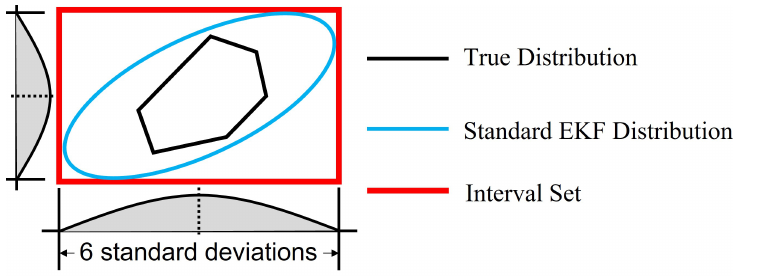
Figure 1. Illustration of the interval set containing the distribution of